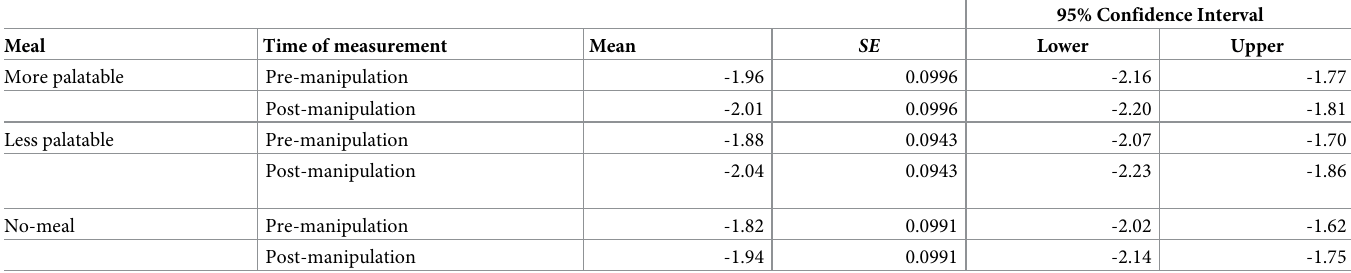
Table 1. Mean levels of participants’ discount parameters (log k ) for pre-manipulation and post-manipulation measurements. Lower values indicate steeper dis- counting of future rewards. Meal Time of